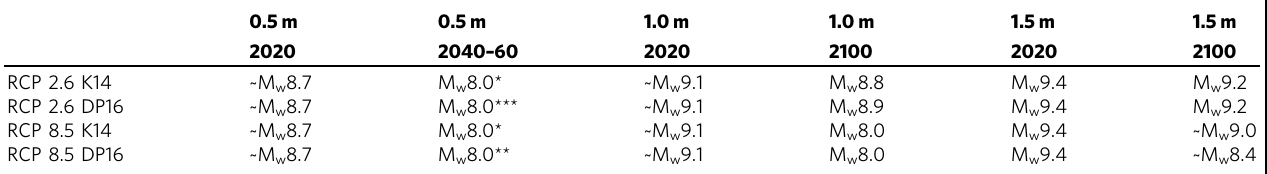
and 2060 (RCP2.6 DP16), a M w 8.0 or lower earthquake generates 0.5 m (Fig. 4a). Along the Alaska-Aleutian subduction zone, a M w 8.0 earthquake is ~3.4 times more likely to occur than a ~M w 8.7 (see “ Methods ” section).